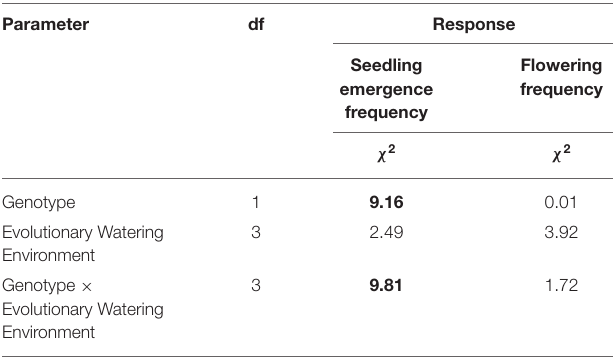
( Table 2 ; mean values presented in Supplementary Table 3